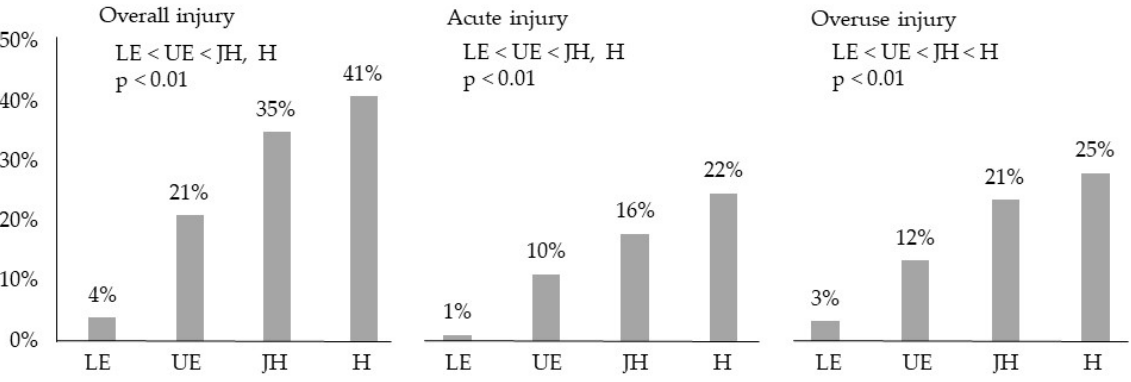
Figure 4. Prevalence of sport-related injuries in each school category. LE: Lower Elementary School, UE: Upper Elementary School, JH: Junior High School, H: High School.